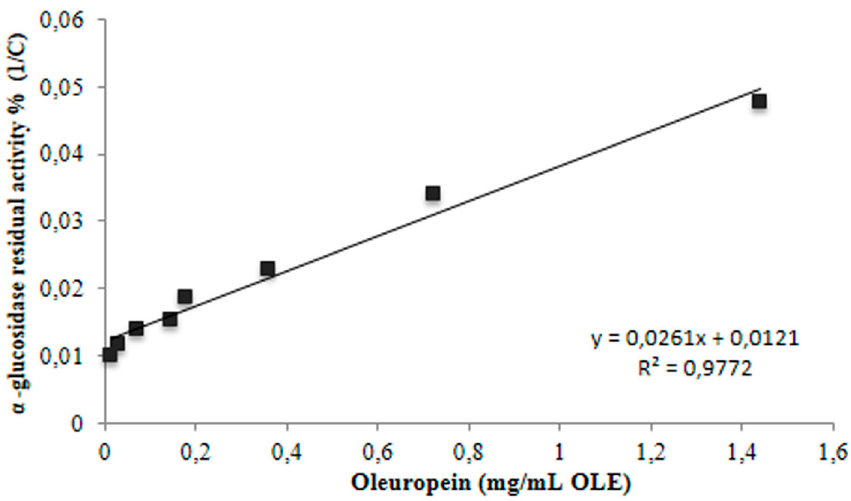
Figure 2. Inhibition of α -glucosidase (IC 50 ) at di ff erent OLE concentrations.